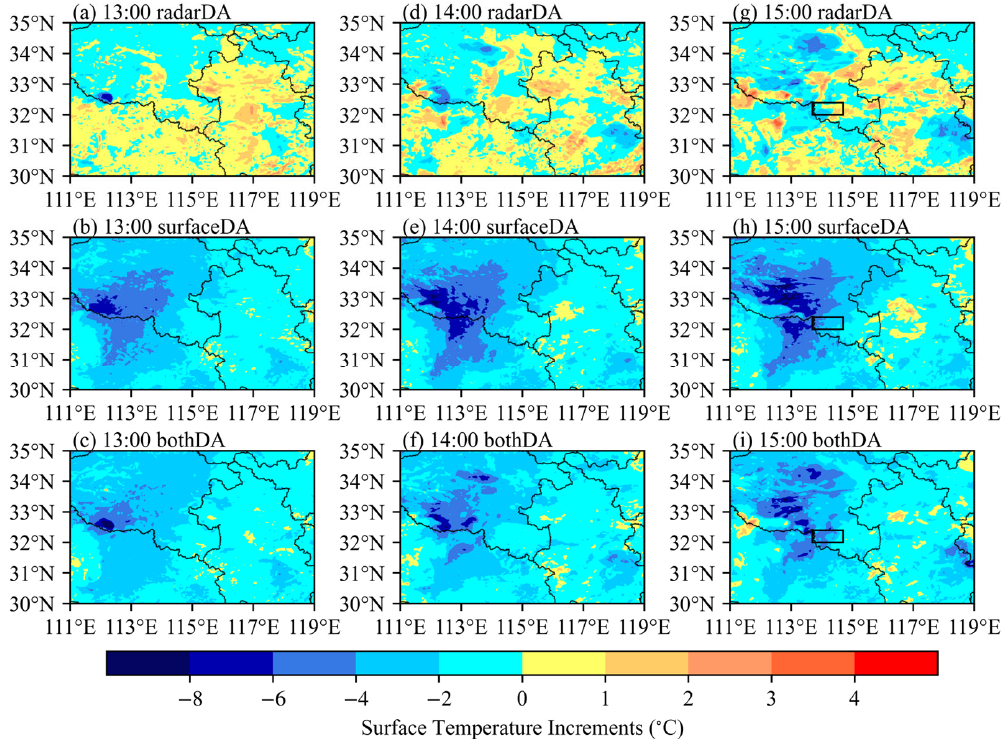
Figure 9. The surface temperature increments of the three assimilation experiments (shaded, unit: °C) at ( a–c ) 1300, ( d–f ) 1400 and ( g–i ) 1500 UTC 11 July 2014. The black box in ( g – i ) is where the squall line initiated.